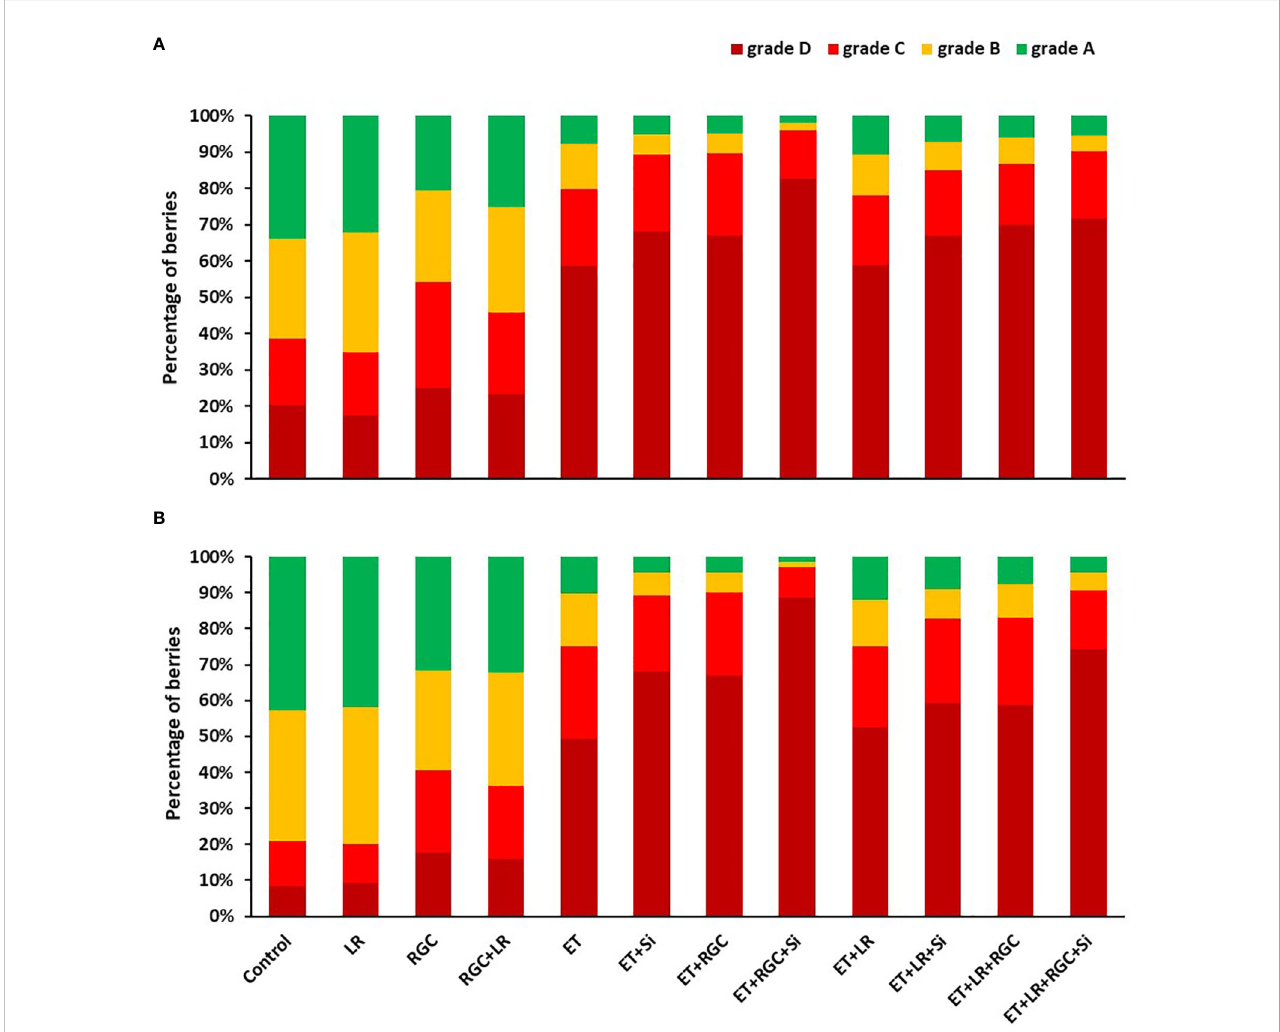
FIGURE 4 Percentage of Flame Seedless berries that fall within the different color categories as affected by the different treatments in 2019 (A) and 2020 (B) . Treatments were: ethephon (ET), silicon 7% (Si), light-re fl ective ground cover (RGC), and their combinations. Treatments have been conducted with or without cluster-zone leaf removal (LR). The different four color categories are: Grade A: berries with 25% color or less; B: berries with 25-50% color; C: berries with 50-75% color, and D: berries with 75-100% red